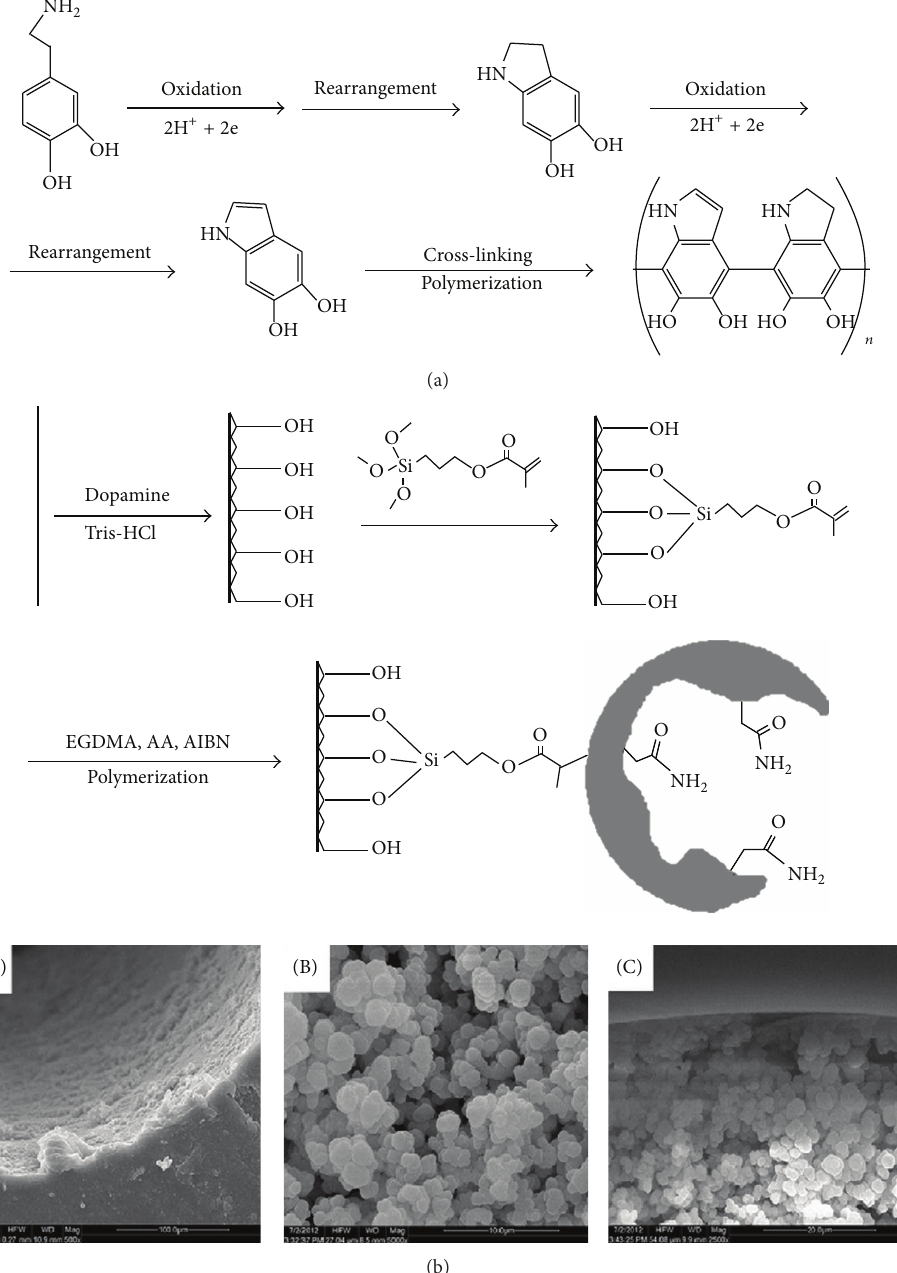
Figure 4: Schematic of (a) the formation of polydopamine layer and (b) modification of PEEK tube and preparation of poly(AA-EGDMA) monolith and Scanning electron micrograph of (A) polydopamine layer on the inner wall of PEEK tube, (B) poly(AA-EGDMA) monolith, and (C) interface of inner wall of PEEK tube and polymer monolith